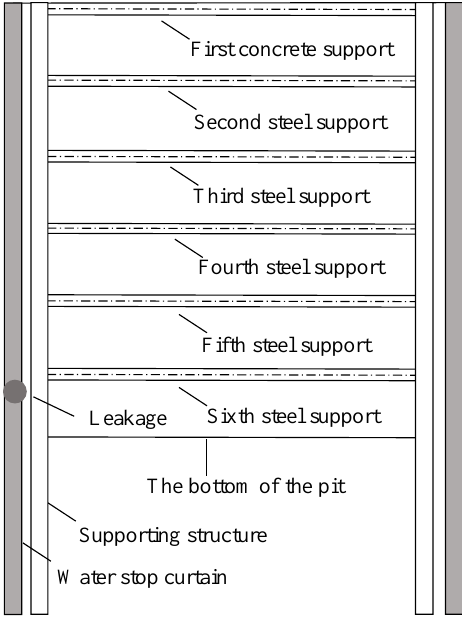
Figure 4. Foundation pit structure and leakage location.